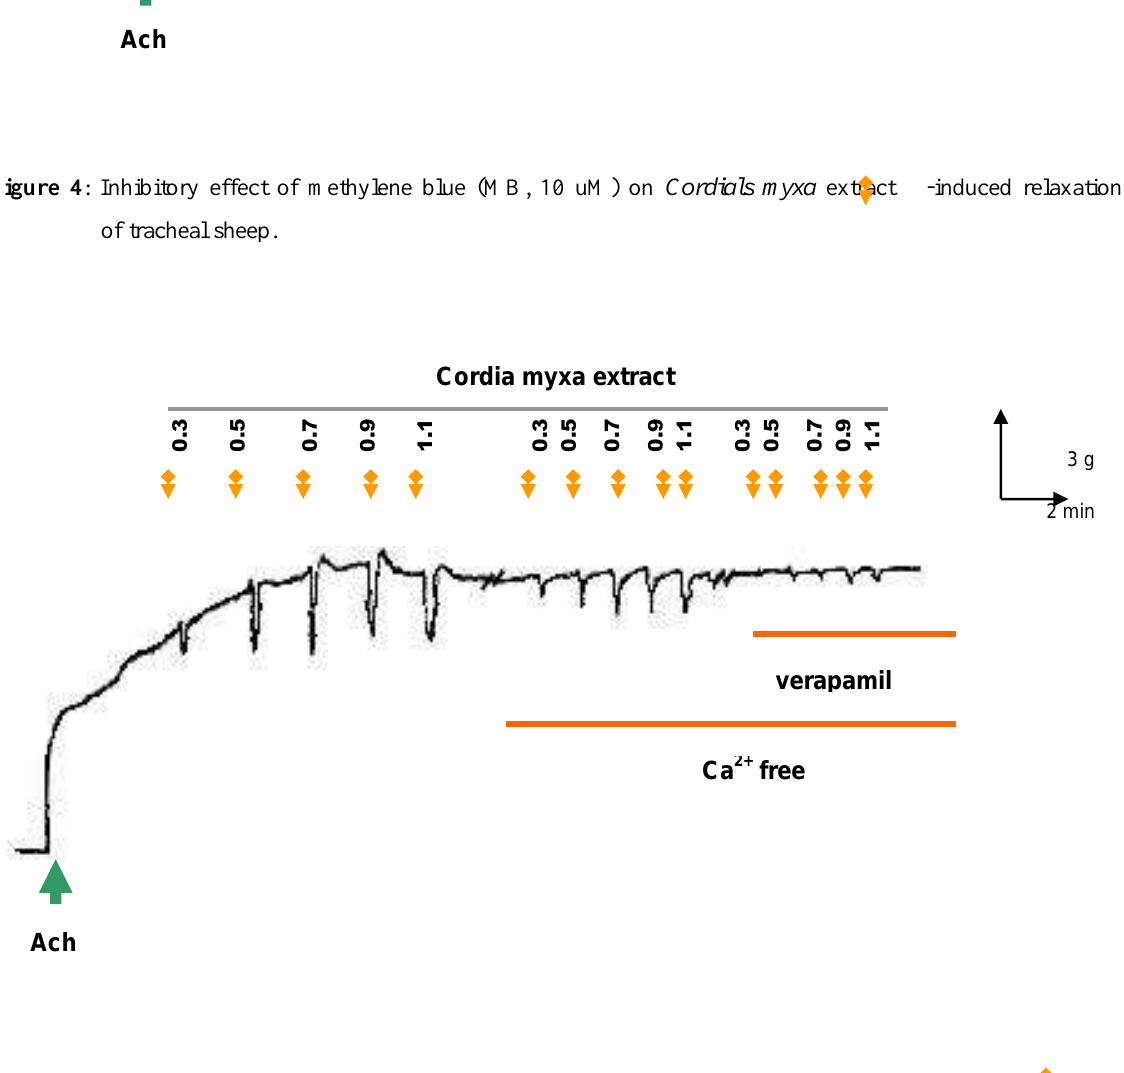
Figure 5 : Tracing of the inhibitory action of Ca 2+ -free and verapamil (0.1 uM) on Cordia myxa extract - induced